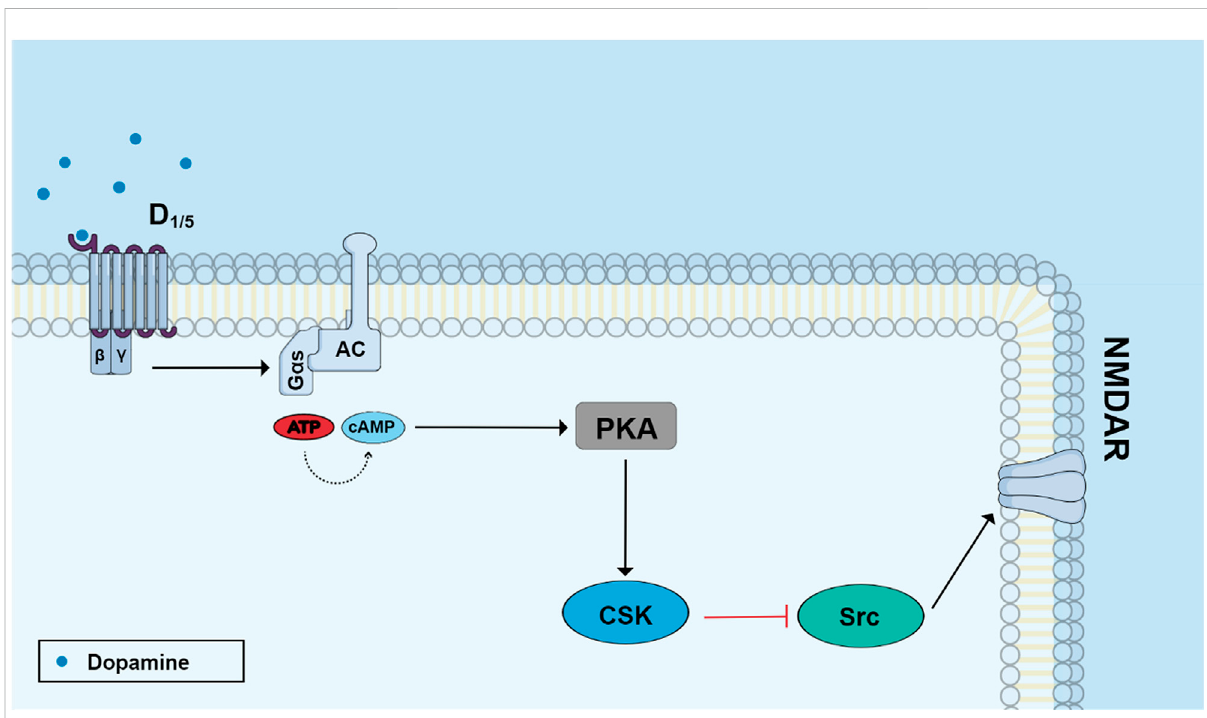
FIGURE 4 Dopamine regulates NMDA receptor function through the PKA/CSK/Src pathway. Stimulation of D1-like receptors with dopamine activates adenylyl cyclase and increases cyclic AMP production. Activated protein kinase A (PKA) induces the phosphorylation of C-terminal Src kinase (ser 364 Csk) which phosphorylates Tyr 527 Src leading to enzyme inhibition. Src phosphorylates the subunit 2B of NMDA receptor in the residue Tyr 1472 and then Src inhibition leads to diminished receptor